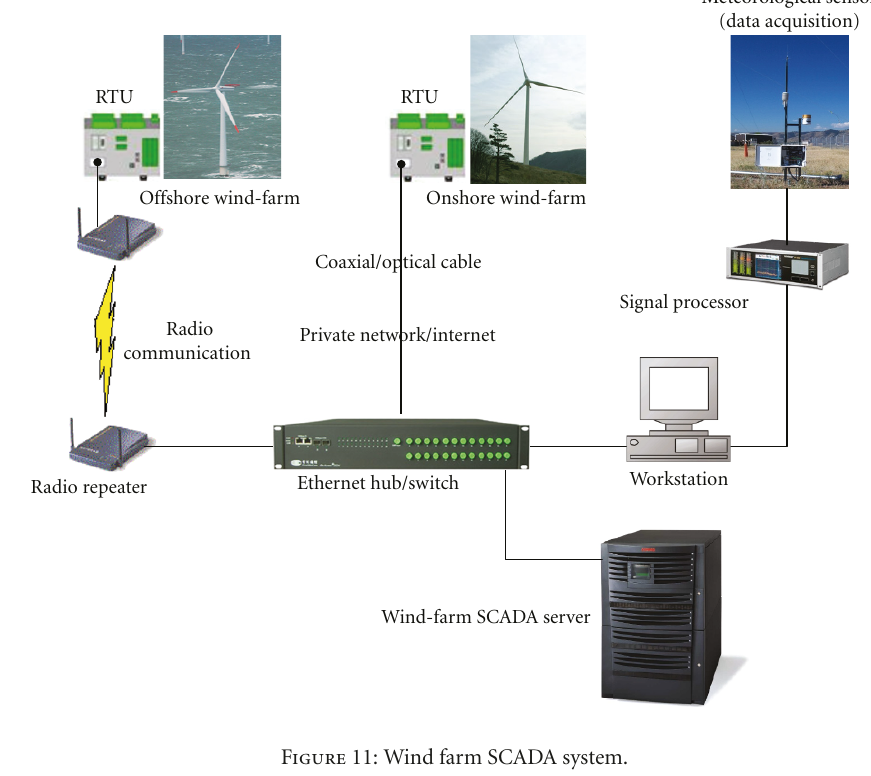
Figure 11: Wind farm SCADA system.